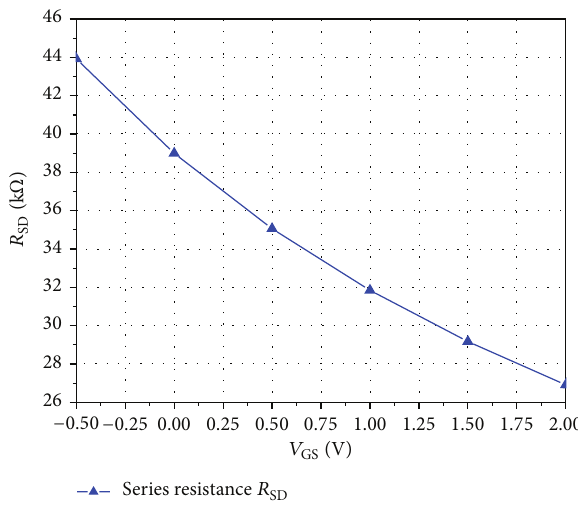
Figure 6: 𝑅 SD versus 𝑉 GS relation for NSB with 4.6 nm channel thick given by (8).